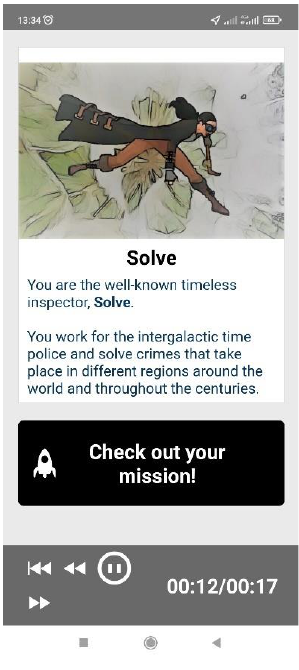
Figure 10. The initial screen of the game.